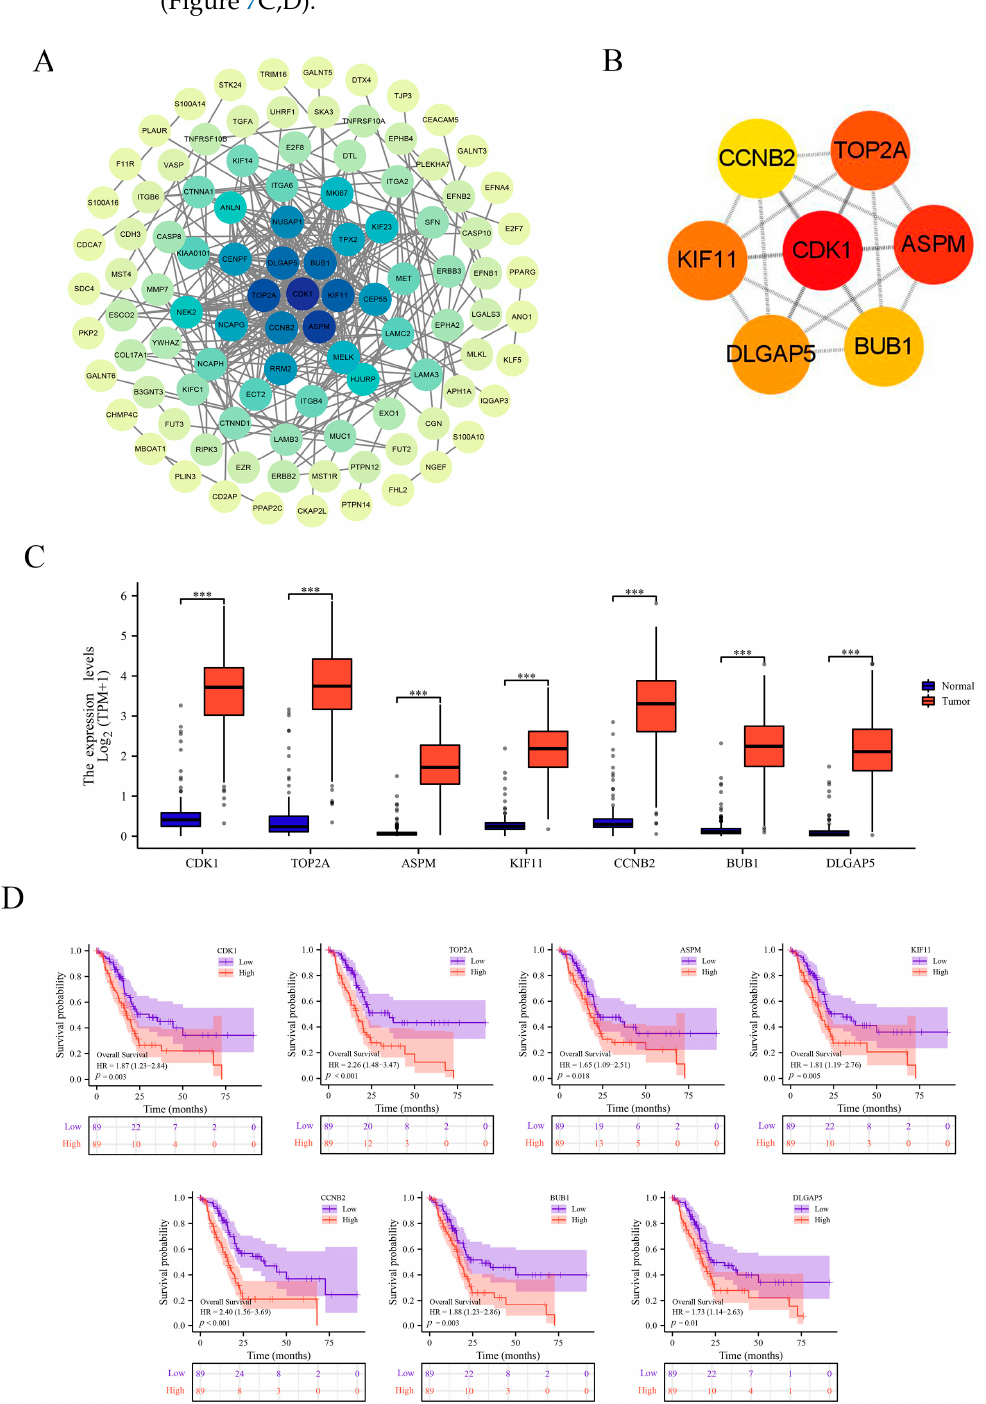
Figure 7. PPI network and hub genes analysis. ( A ) PPI network of top 300 positively related genes. ( B ) hub genes. ( C ) The mRNA expression of hub genes in PAAD. ( D ) The prognostic analysis of hub genes in PAAD. *** p < 0.001.